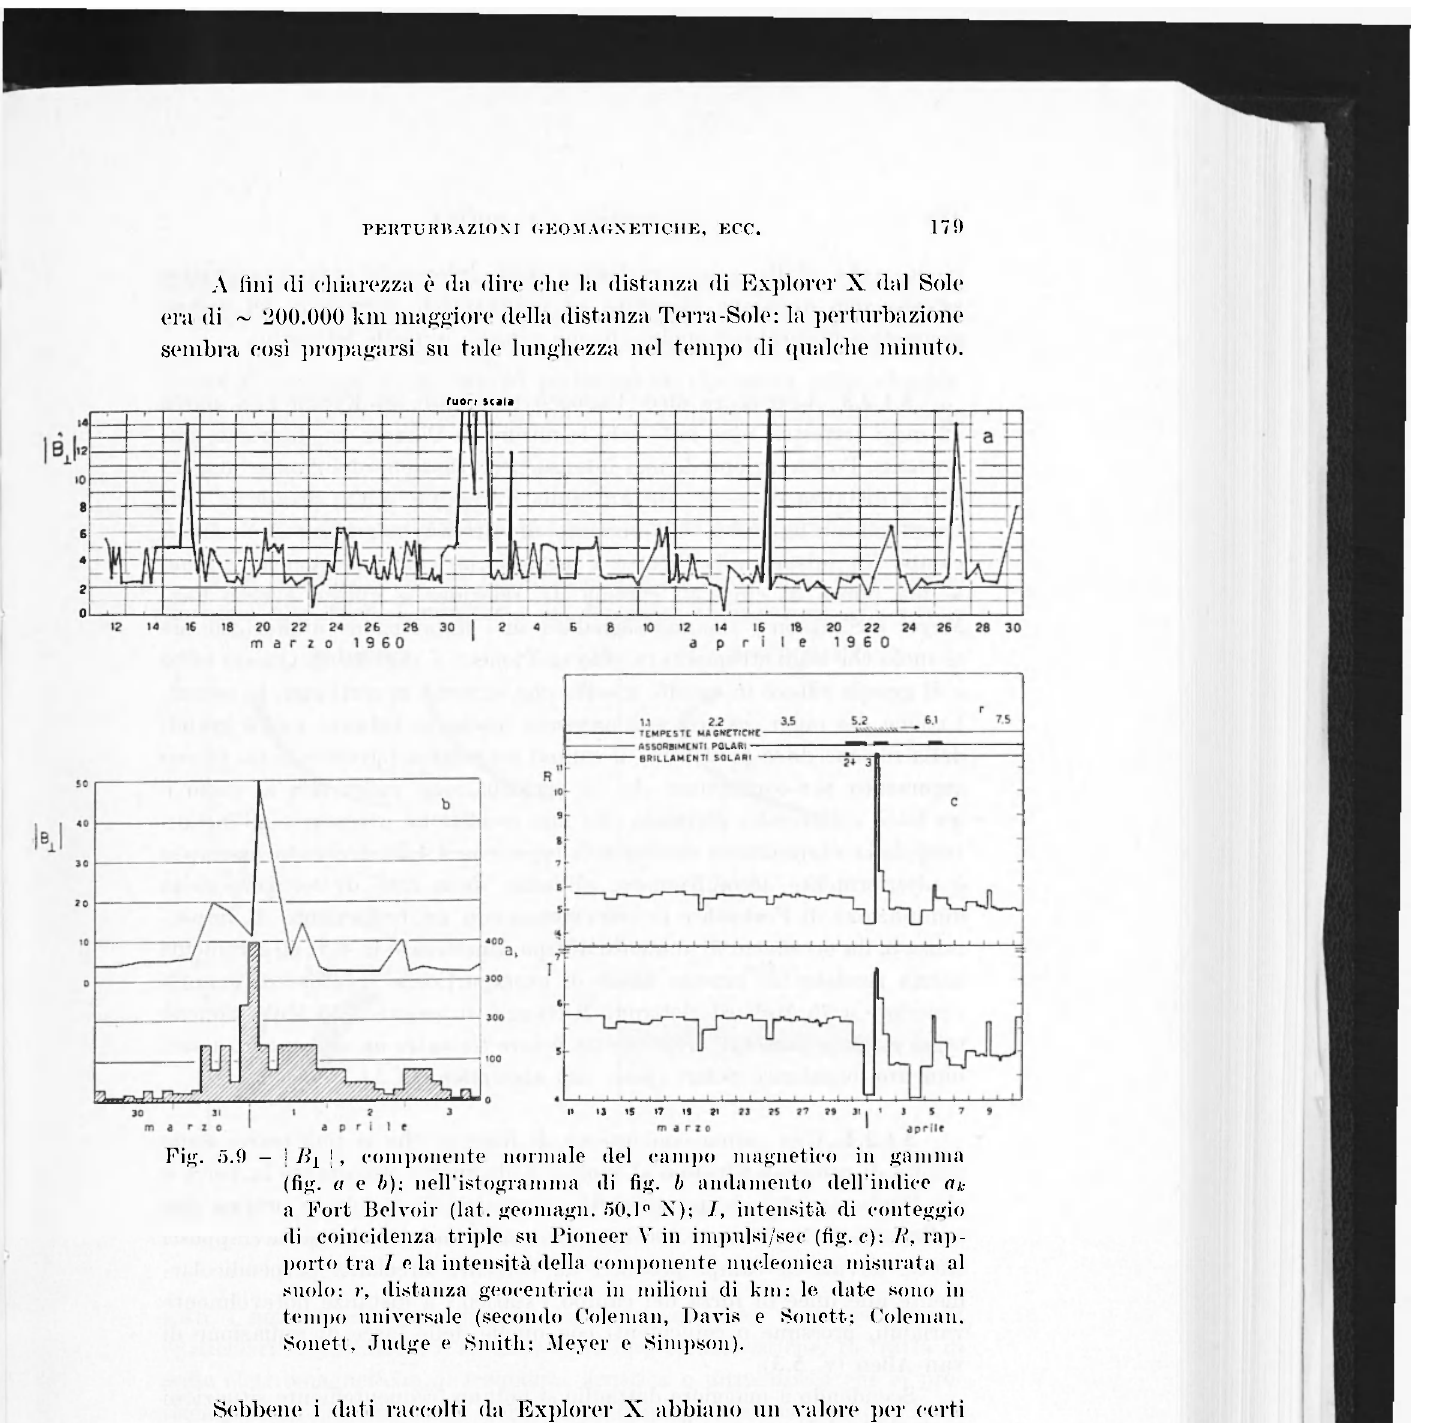
Fig. 5.9 - j | , componente normale del campo magnetico in gamma (fig. a e b); nell'istogramma di fig. b andamento dell'indice a* a Fort Belvoir (lat. geomagn. 50,1° N); 7, intensità di conteggio di coincidenza triple su Pioneer V in impulsi/sec (fig. c): li, rap- porto tra 1 e la intensità della componente nucleonica misurata al suolo; r, distanza geocentrica in milioni di km; le date sono in tempo universale (secondo Coleman, Davis e Sonett; Coleman. Sonett, Judge e Smith; Meyer e